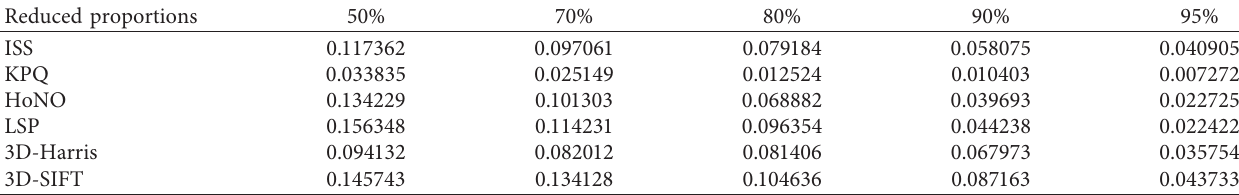
of the key point detection algorithm on the Space Time data set. density